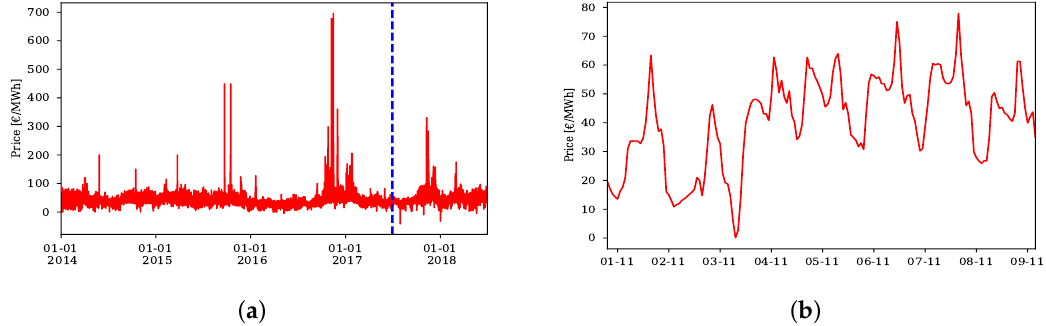
Figure 1. Belgian DAM prices. ( a ) Historic DAM prices, covering the training and test spans: 1 January 2014 to 30 June 2018. The dashed blue line represents the train / test split. ( b ) Single week of DAM prices from 1 November 2014 to 9 November